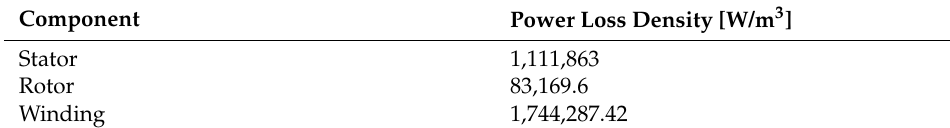
Table 7. Power loss density of the components at maximum power.